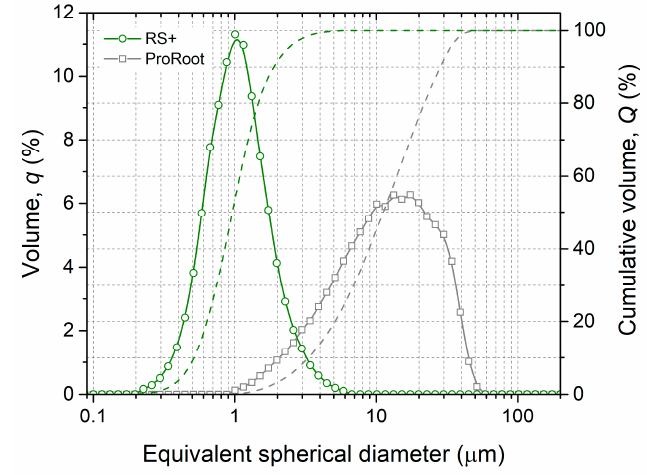
Figure 3. Particle size distributions of as-received hydraulic cements.